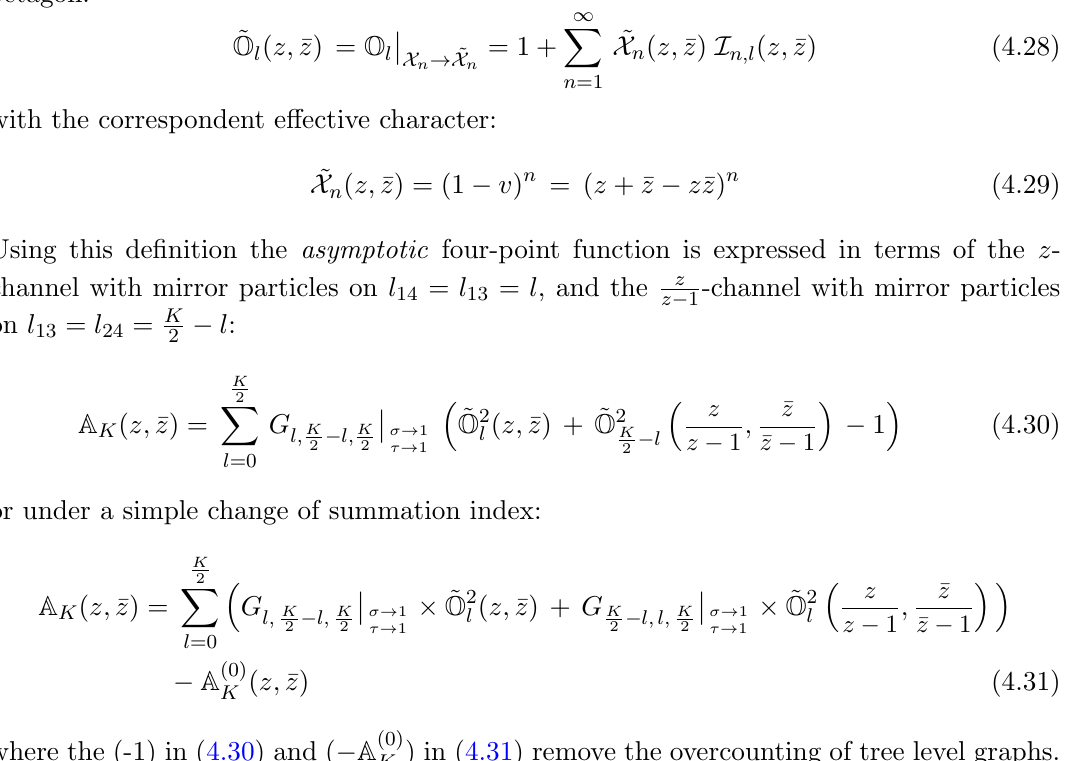
l and the decouple 2 (cid:0)